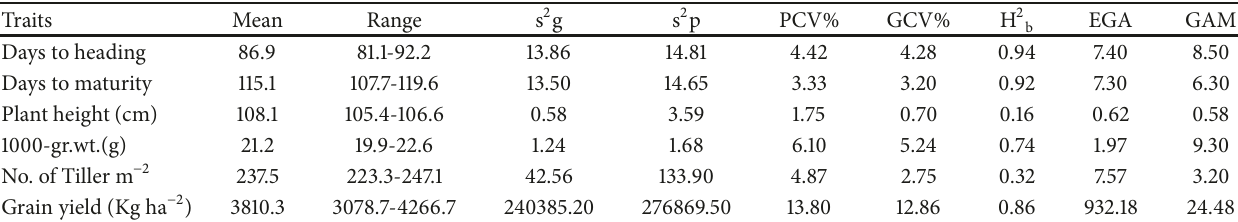
Table 4: Estimation of means, ranges, variance components, phenotypic coefficient of variations, genotypic coefficient of variations, broad senseheritability, geneticadvanceand geneticadvanceas percentof mean of yield and yield traits of early maturing riceunderrainfed lowland environment of